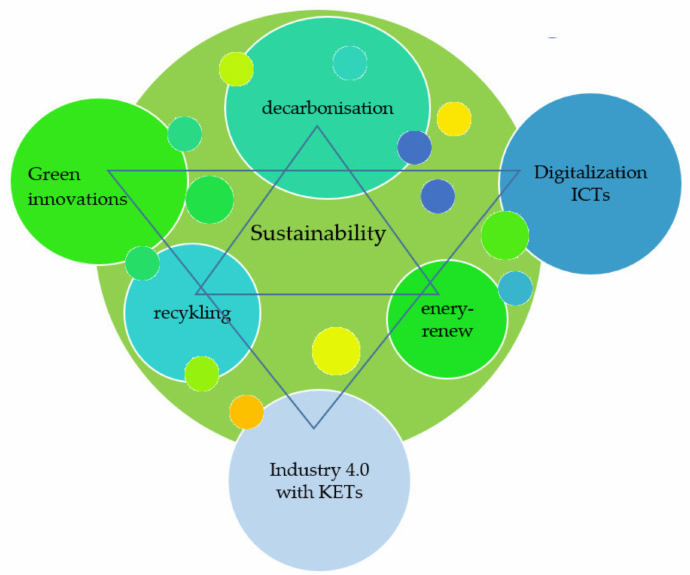
Figure 2. The frameworks for R&D&I in the steel industry. Source: adapted with permission from Ref.